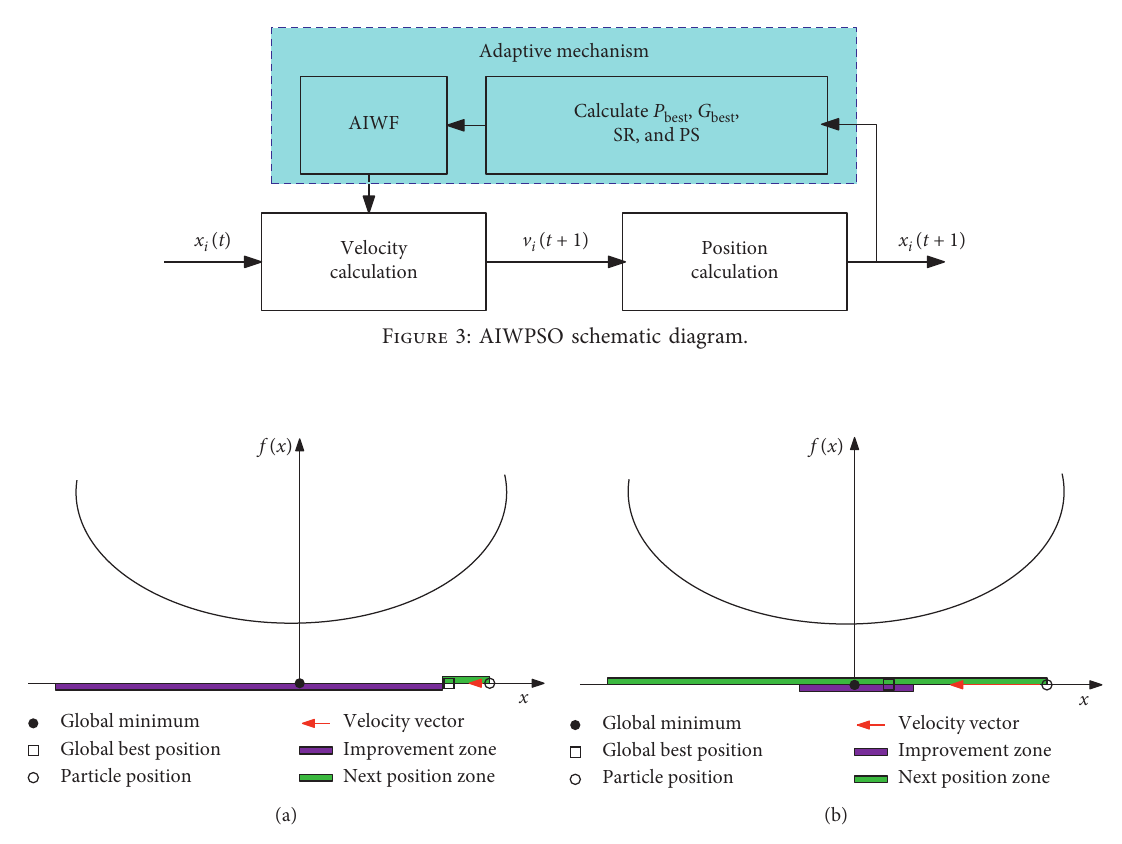
Figure 4: AIWPSO Scenarios. (a) Near global solution. (b) Far from global solution.